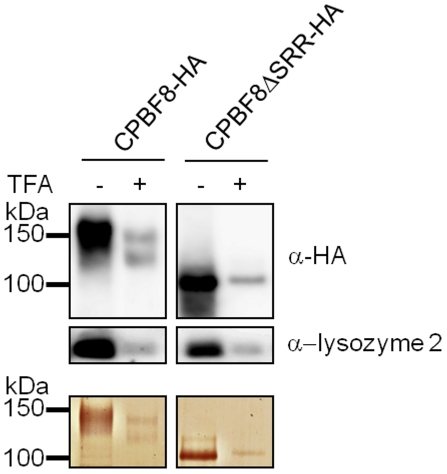
Post-translational modification of CPBF8.CPBF8-HA and CPBF8ΔSRR-HA was immunoprecipitated with anti-HA antibody from the lysates of CPBF8-HA and CPBF8ΔSRR-HA transformants, treated (+) or untreated (−) with TFA for 10 min. The samples were separated on SDS-PAGE and silver-stained (bottom panel), or blotted and reacted with anti-HA (top panel) or anti-lysozyme 2 antibody (middle panel). The apparent molecular weight (kDa) of standards are indicated on the left.